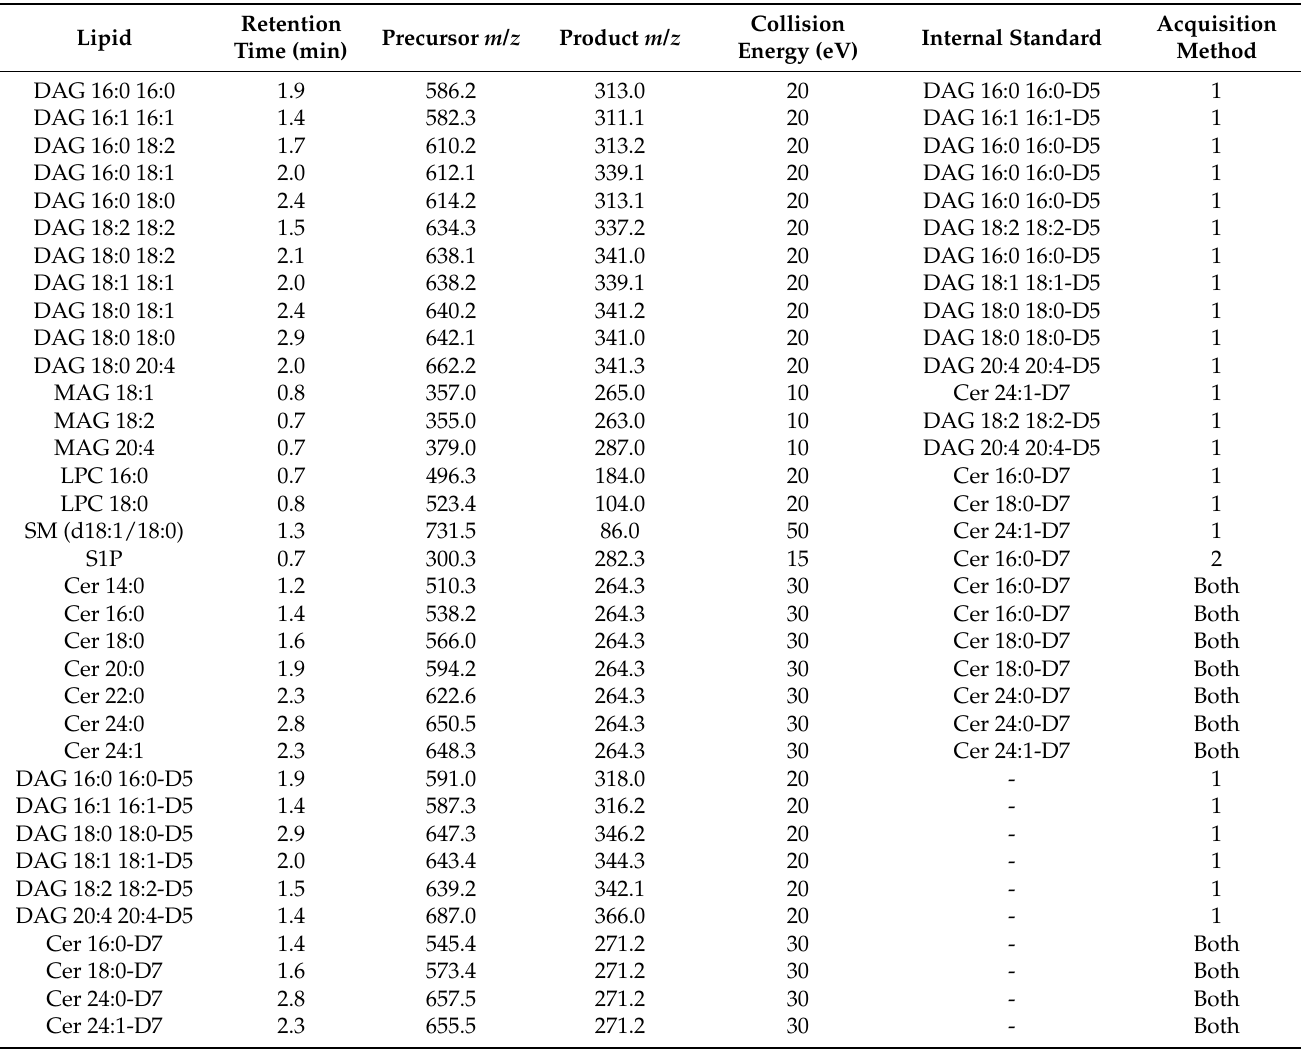
Table A1. Retention times and transitions for detection of lipids using